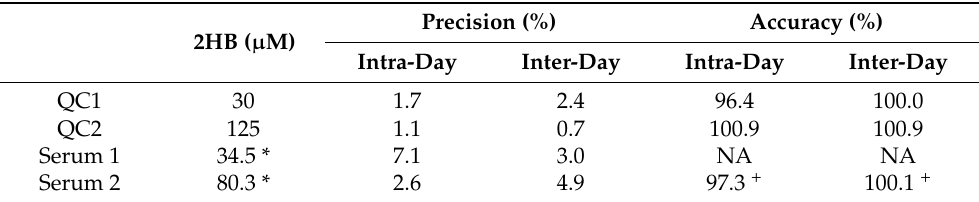
Table 2. Intra-day ( n = 5) and inter-day ( n = 5) precision and accuracy values of 2HB measurements in quality control and serum